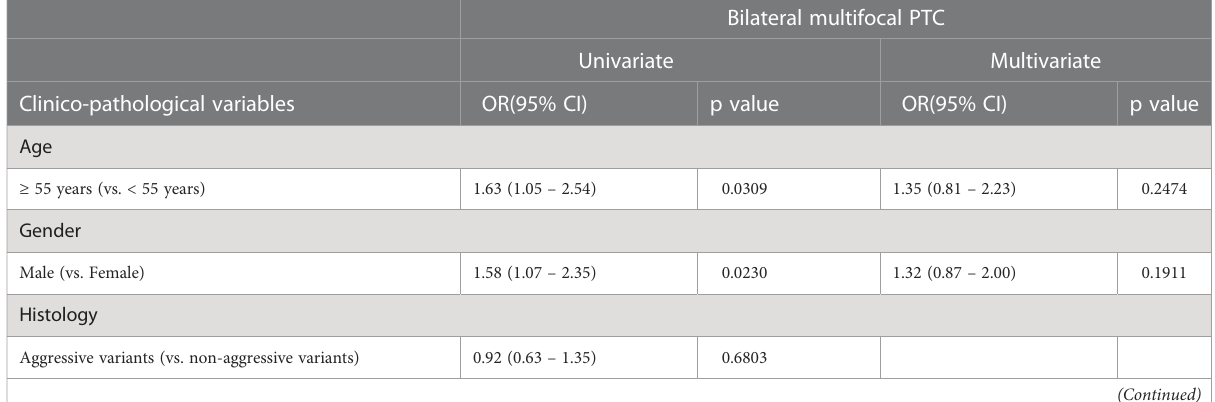
TABLE 4 Multivariate analysis using logistic regression model for predictors of bilateral multifocality in